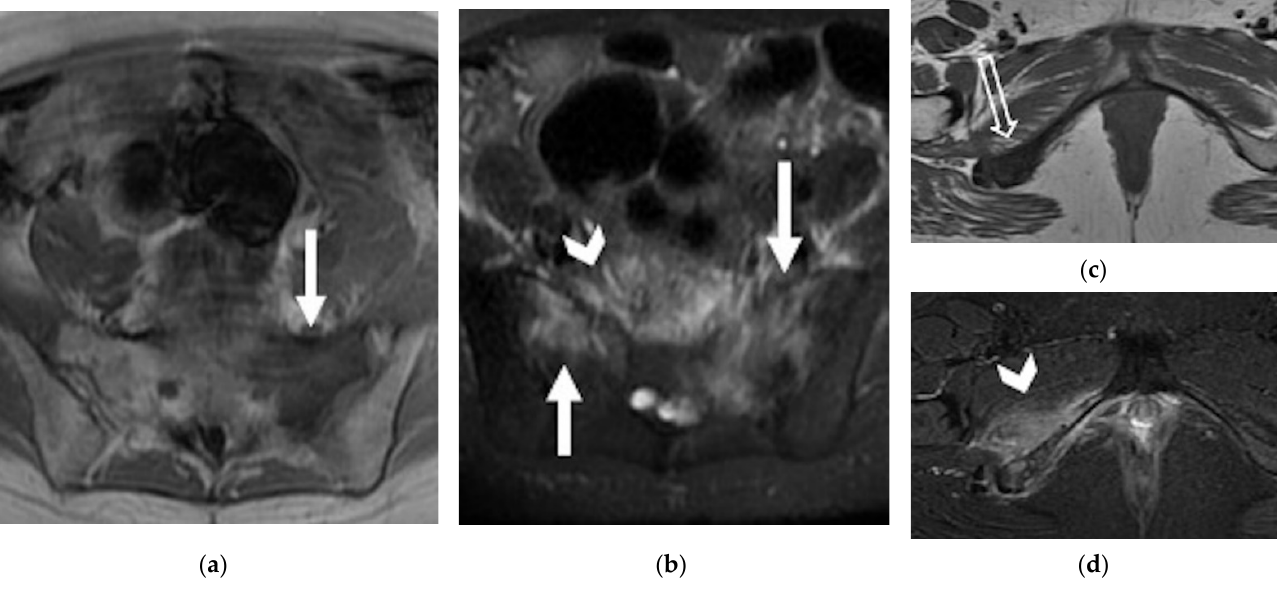
Figure 10. ( a , b ) A 56-year-old patient who underwent radical hysterectomy with BSO and chemoradiation therapy for cervical cancer. ( a ) Axial FSE T1 weighted and ( b ) axial FSE T2-weighted fat-sat images show osseous metastases in the sacrum, characterized by hypointense T1 and hyperintense T2 signal intensity (solid arrows). ( c , d ) A 41-year-old patient who underwent previous chemoradiation therapy for cervical cancer. ( c ) Axial FSE T1 weighted and ( d ) axial FSE T2-weighted fat-sat images show osseous metastases in the ischio–pubic right branch (open arrow in c ). Note the oedema in the adjacent soft tissue and muscles (arrowheads in ( b , d )).